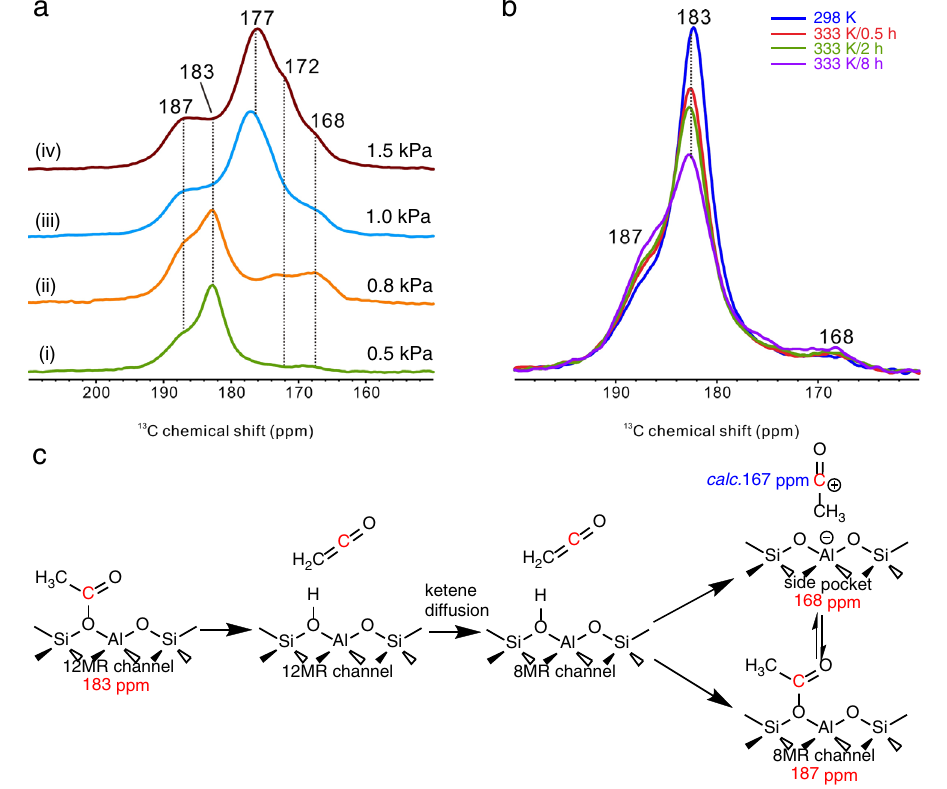
b In situ 13 C MAS NMR spectra of CH 3 13 COCl adsorbed on dehydrated H-MOR zeolite at different reaction conditions. c Assignation to chemical shifts, and the evolution of ketene, surface acetyl and acylium ion in different